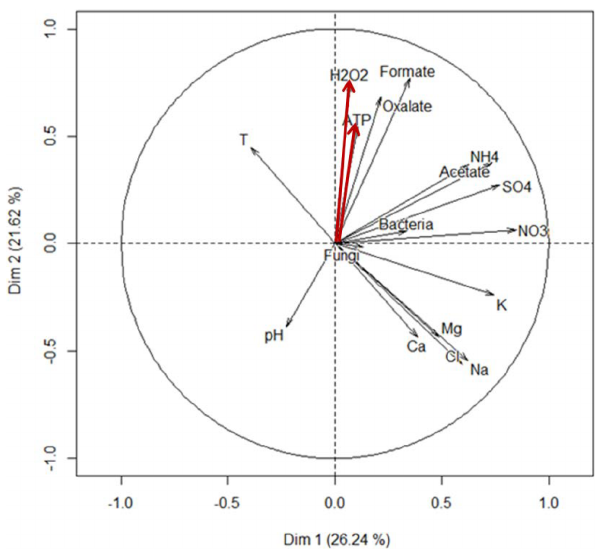
Figure 4. Variables’ factor map (PCA) of the 37 cloud events on the PC1-PC2 plane based on 17